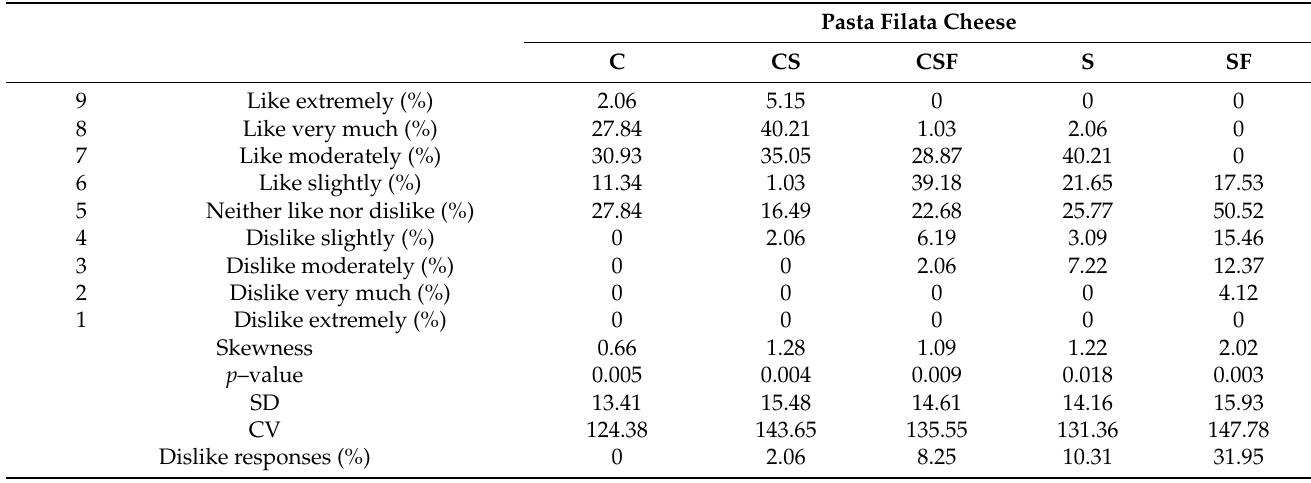
Table 7. Sensory acceptability of pasta filata cheeses from cow’s and sheep’s frozen milk.